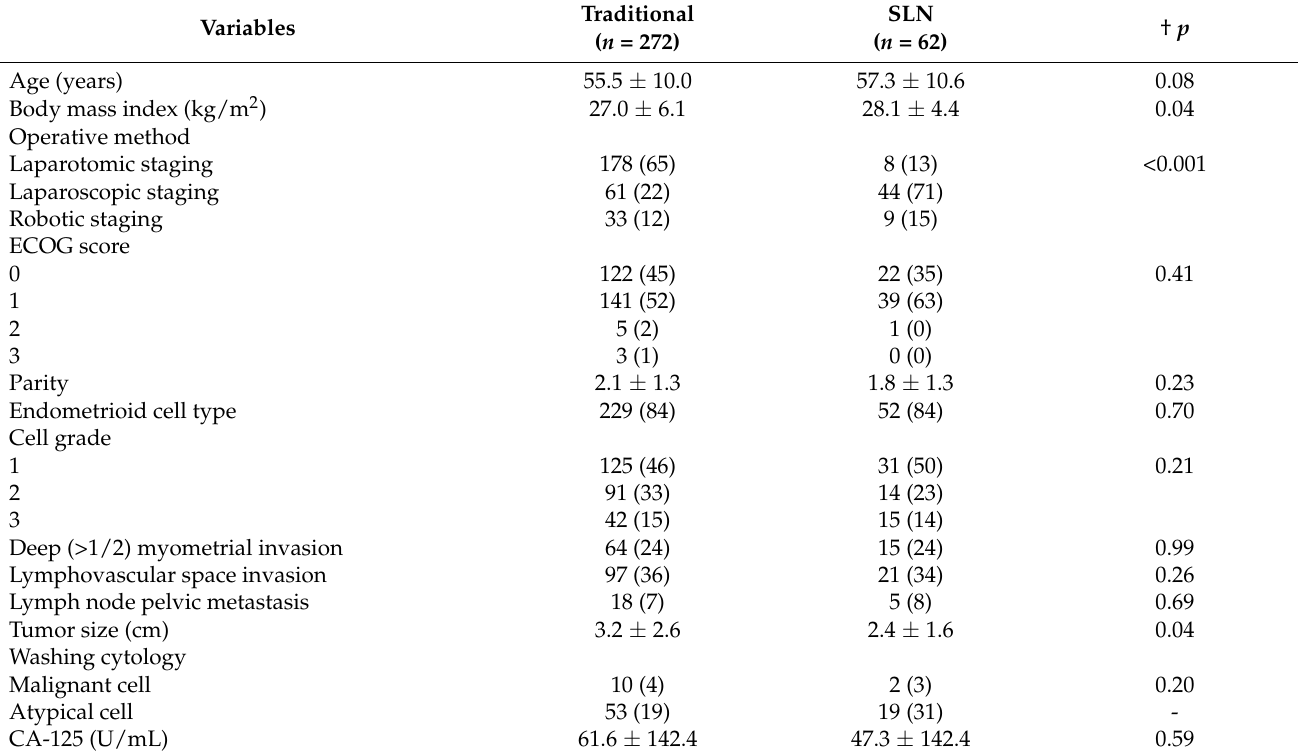
Table 1. Comparisons of the baseline data and clinical outcomes between the traditional lym- phadenectomy and sentinel lymph node mapping groups in women with clinically uterine-confined endometrial cancer ( n =